Question: In one sentence, what is this figure communicating?
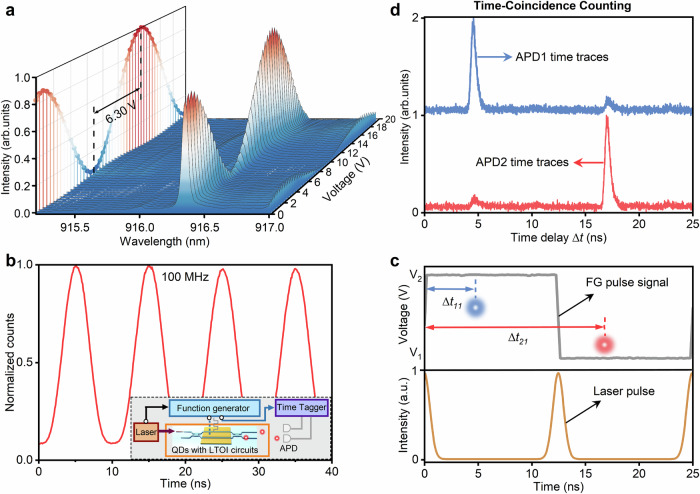
Answer: On-chip single-photon routing at cryogenic temperatures. a The spectra mapping of the QD’s emission under different voltages applied to the modulation electrode by a DC voltage source. The left panel presents the cryogenic electro-optic characterization, revealing the measured half-wave voltage. b Example of a sinusoidal modulation of a continuous-wave laser at 100 MHz at 4 K, demonstrating the device’s high-frequency response. The inset shows the experimental setup for on-chip single-photon routing. c The orange curve represents the pulsed laser output signal, while the gray curve indicates the rectangular wave signal synchronously output by the arbitrary function generator to the electrode. The blue and red photons denote their arrival times at the APD from different output ports, illustrating deterministic routing to distinct ports depending on the applied voltage. d Time traces showing the arrival of single photons at two separate output ports.